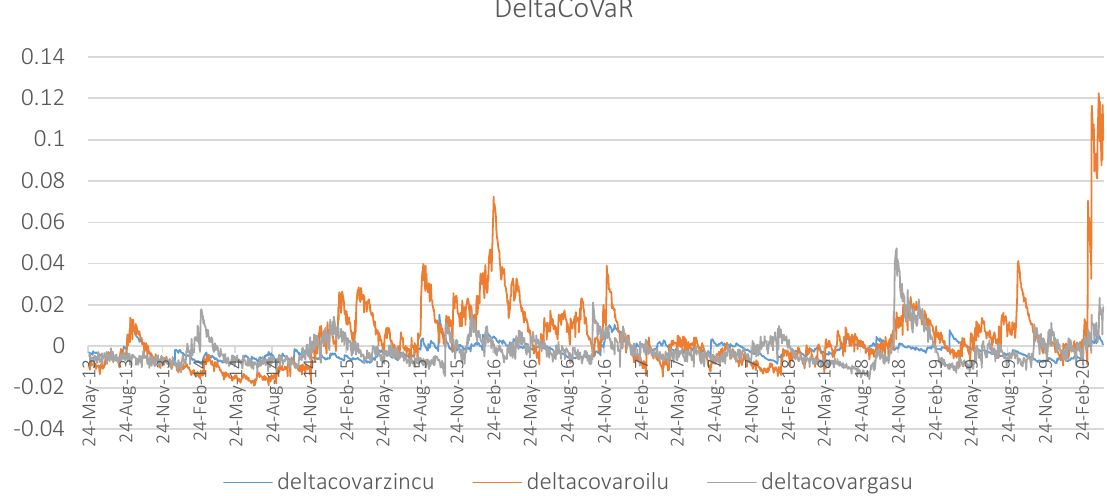
Figure 4. Marginal risk contribution of crude oil futures, zinc futures and natural gas futures returns to stock